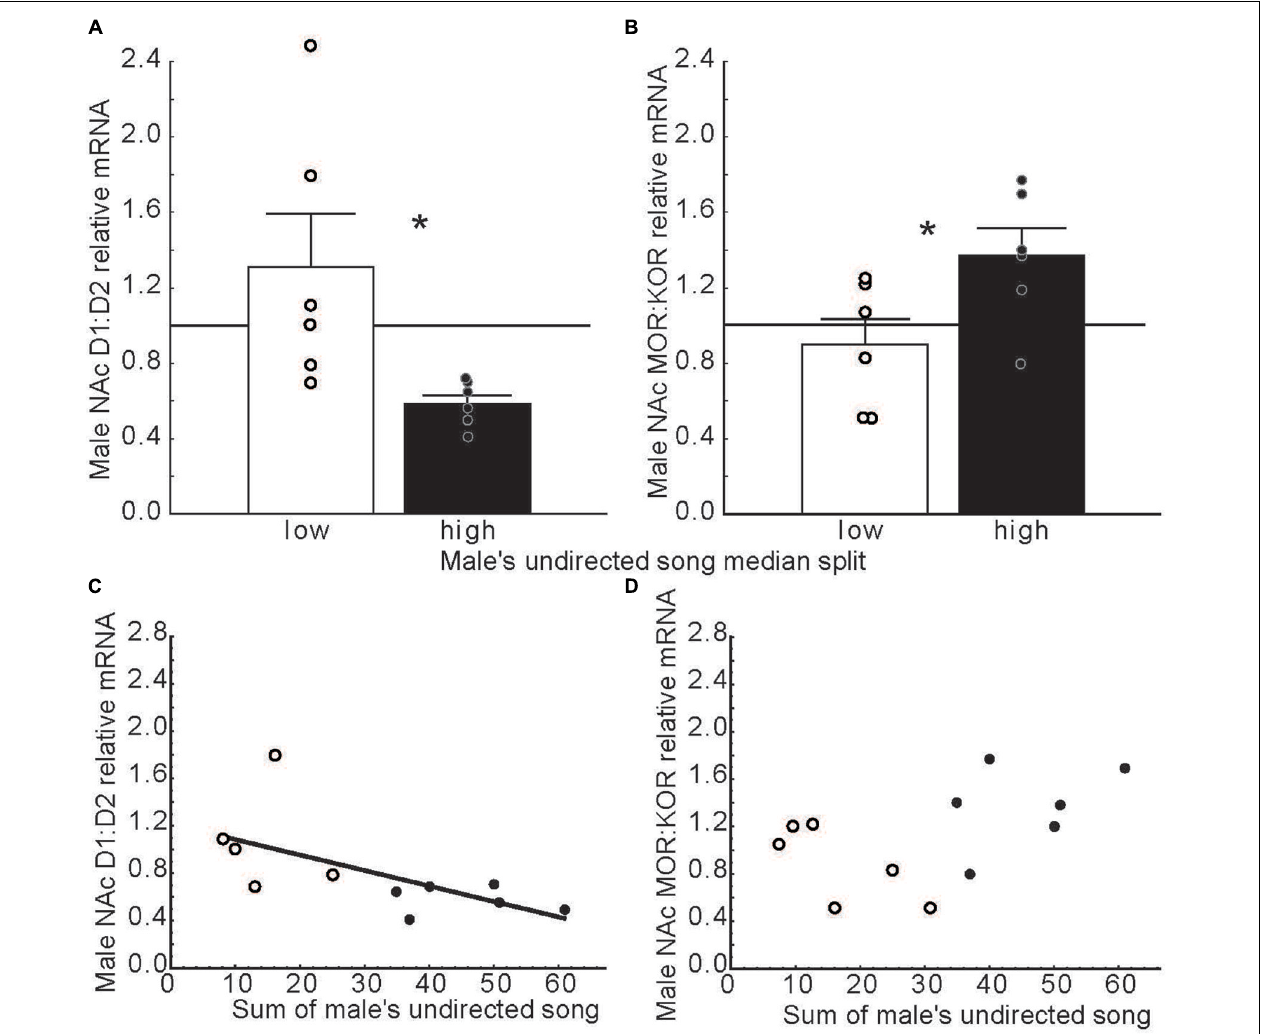
FIGURE 6 | Dopamine and opioid receptor mRNA ratios in NAc differ in males that produce low versus high rates of undirected song. (A,B) Mean relative mRNA ratios + sem for D1:D2 and MOR:KOR in males that produce low (open bars) or high (filled bars) rates of song as determined using a median split. The point at which ratios diverge from 1:1 is indicated by a horizontal line. * = p < 0.05. (C,D) Scatterplots illustrating relationships between dopamine and opioid receptor mRNA ratios in NAc and undirected song in males. Each point represents an individual male. Open dots indicate low and filled dots represent high singers in bar graphs. The regression line indicates a significant correlation ( p < 0.05). Data from Alger et al. (2021). Reproduced with permission.